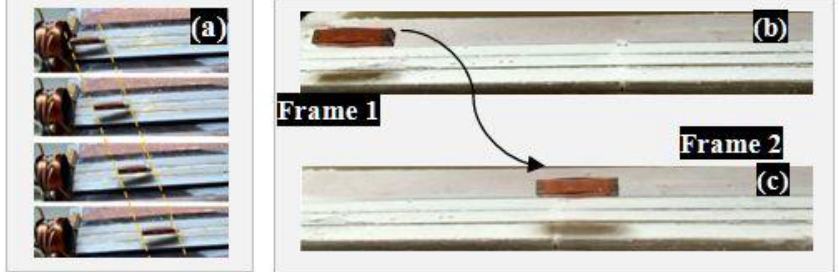
Figure 4. One-stage accelerator: magnetic acceleration of the levitating HTSC-Sabot from Gd123. In ( a ): results of proof-of-principle (POP) experiments: HTSC-sabot ( ≤ 30 mm) levitates over the linear PMG-system (~30 cm); in ( b , c ): the HTSC-Sabot looks like it is attached to a magnetic track.